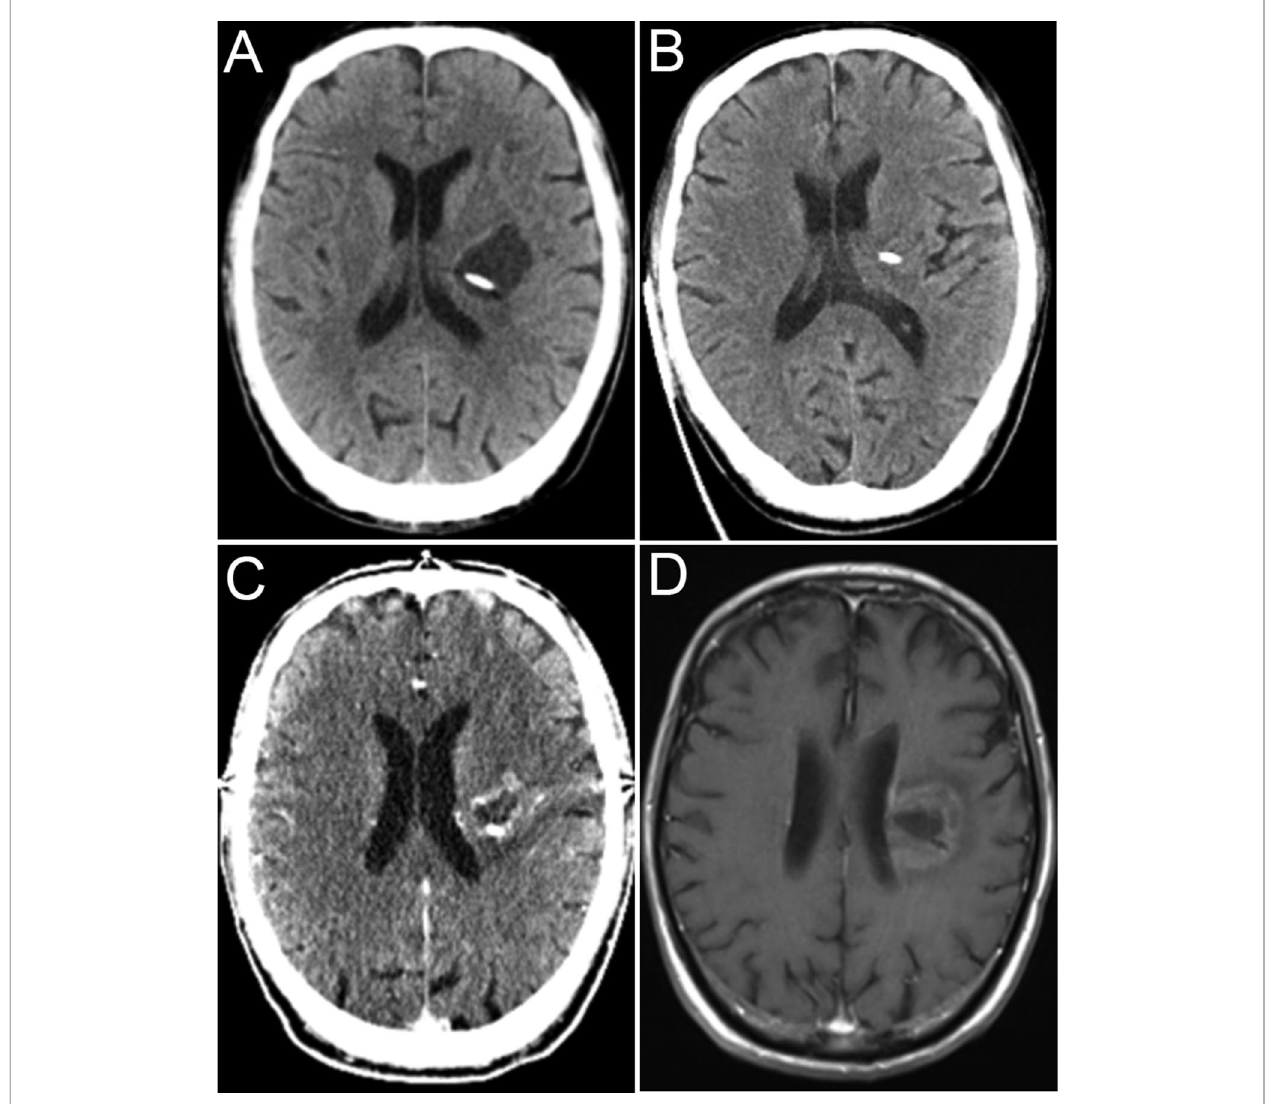
FIGURE 3 | CT image showing fl uid reaccumulation ( A ). CT image immediately after aspiration via the OR ( B ), CT image after fi rst radiosurgery ( C ), and fi nal imaging follow-up ( D